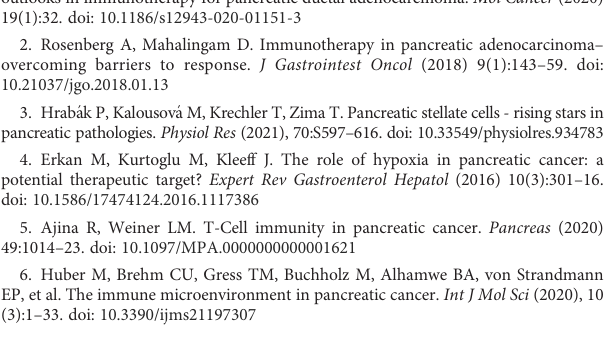
SUPPLEMENTARY FIGURE 1 Characterizationofcells. (A)